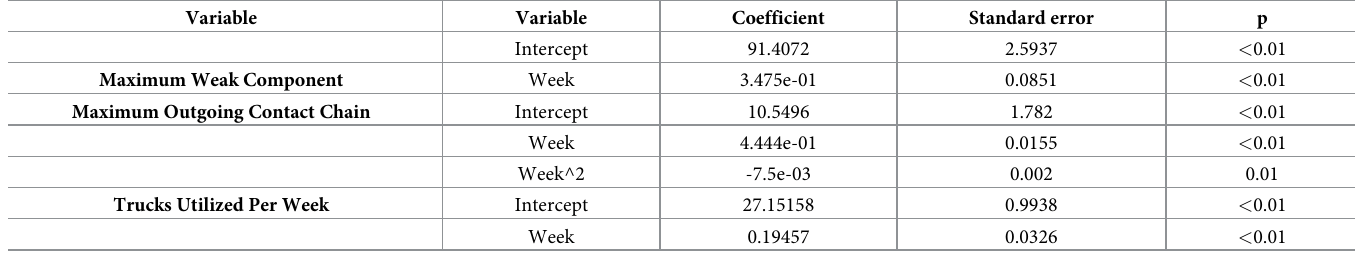
Table 5. Linear regression results for weekly maximum weak component, outgoing contact chain, and truck utilization per week, different functional forms of explanatory variables displayed were relevant.